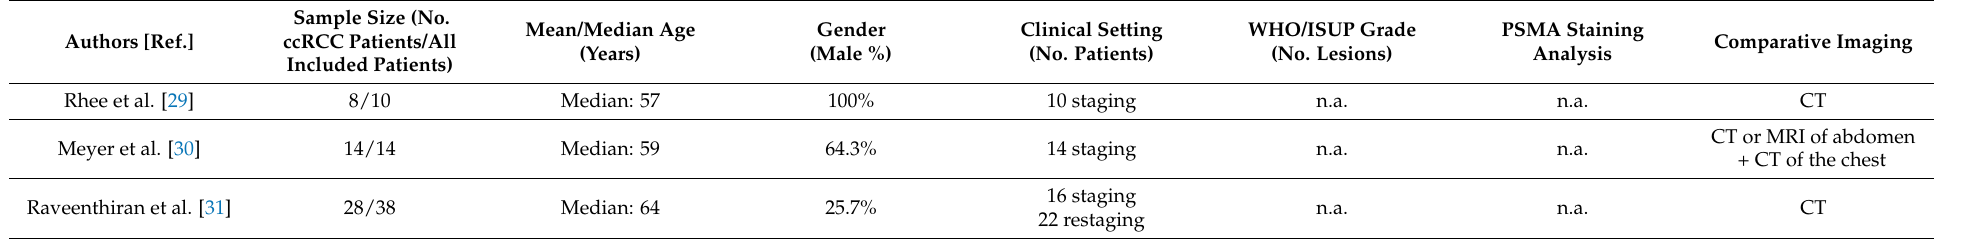
Table 2. Patient key characteristics and clinical settings. Authors